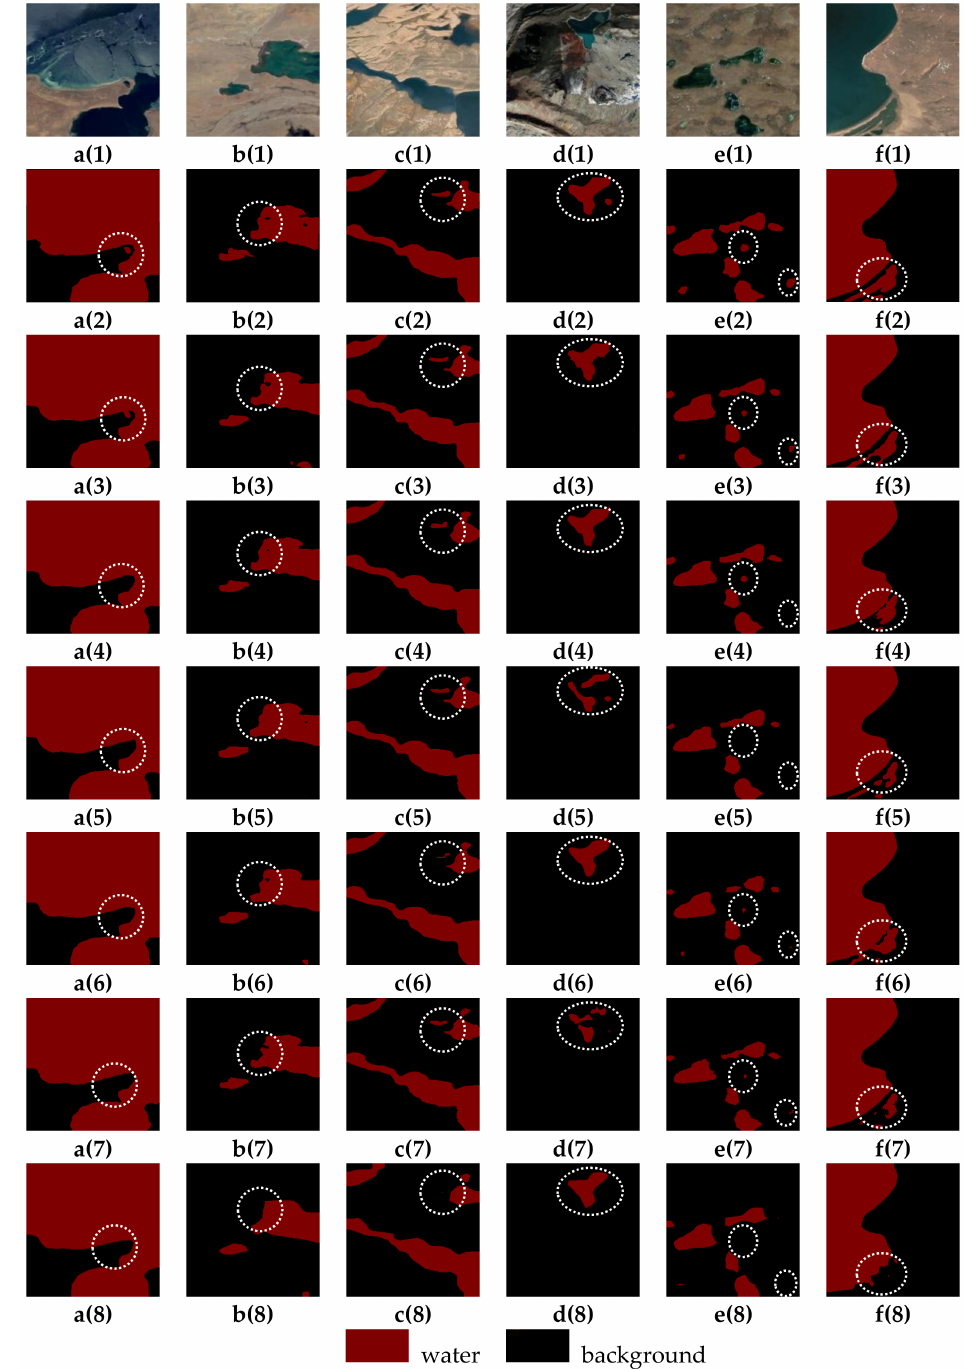
Figure 8. Visualization results for the QTPL dataset: a(1) – f(1) , images; a(2) – f(2) , ground truth; a(3) – f(3) , MSNANet; a(4) – f(4) , Attention U-Net; a(5) – f(5) , DeeplabV3+; a(6) – f(6) , PSPNet; a(7) – f(7) , SegNet; a(8) – f(8) , LANet. The white circles indicate obvious differences. The statistical results of the ablation study are summarized in Table 5. For the SW dataset, after removing FEH, the OA, F1-score, kappa, WIoU, and MIoU decreased by 0.22%, 0.49%, 0.00694, 0.85%, and 0.61%, respectively. Meanwhile, the training time of each epoch increased by more than four-fold. After removing OASPP, the OA, F1-score, kappa, WIoU, and MIoU decreased by 0.11%, 0.21%, 0.00377, 0.36%, and 0.34%, respectively. Moreover, the amount of parameters decreased to 39.6 M. This means that OASPP introduces